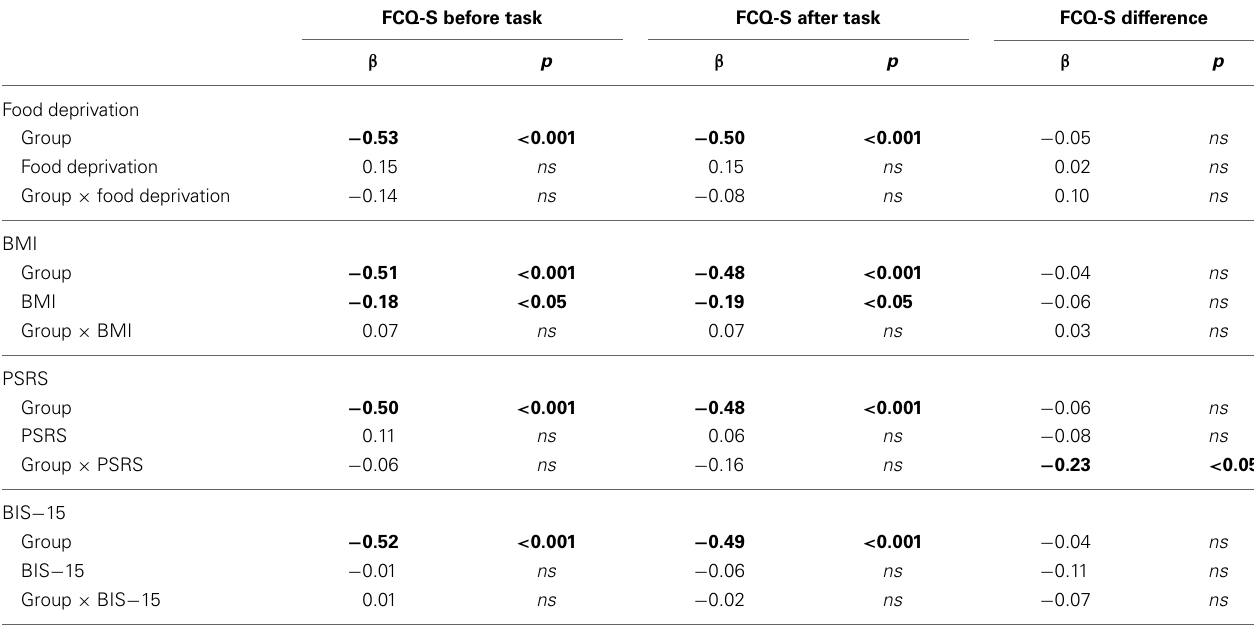
Table 4 | Prediction of state food craving as a function of food deprivation, BMI, dieting success, impulsivity, and group (study 2).